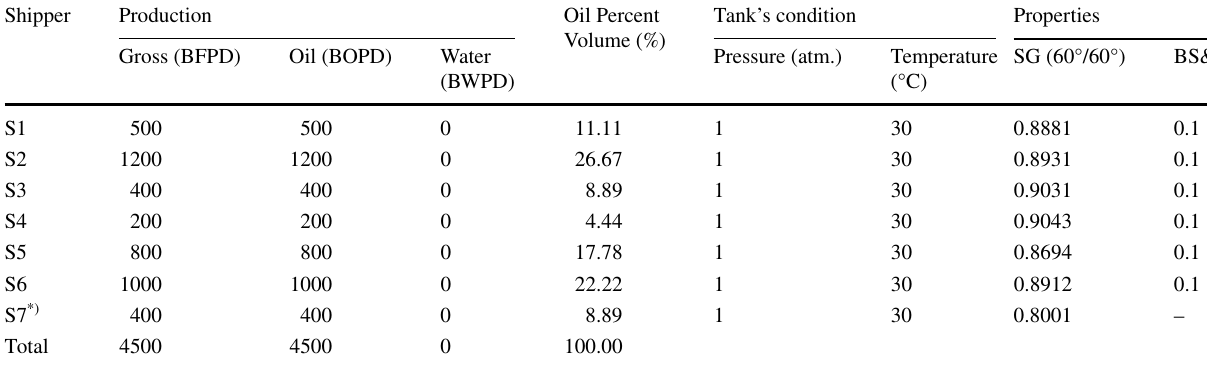
Table 1 Production rate Krisna field and its properties